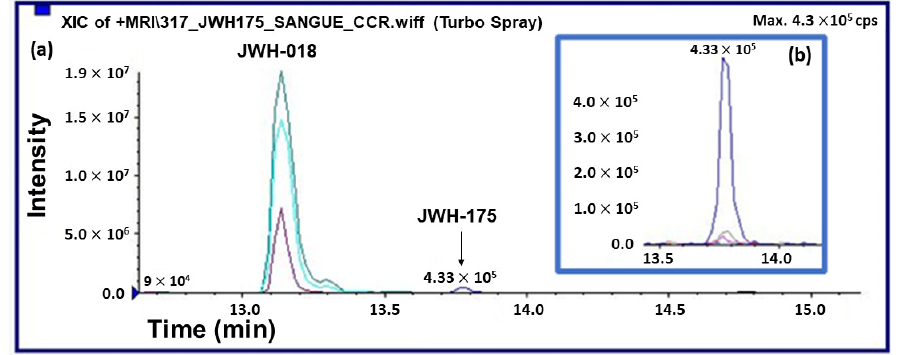
Figure 7. Extracted chromatogram of a representative plasma sample collected from mice after 30 min by the intake of JWH-175 ( a ). Chromatogram enlargement of the plasma level section of JWH-175 ( b ).